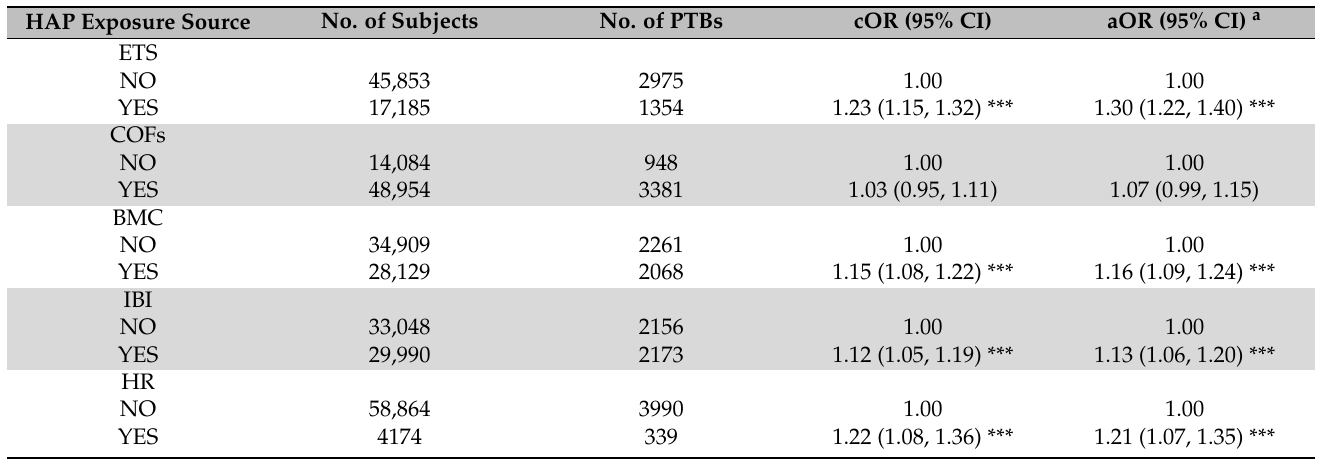
Table 3. PTB risk attributable to prenatal exposure to individual HAP sources during